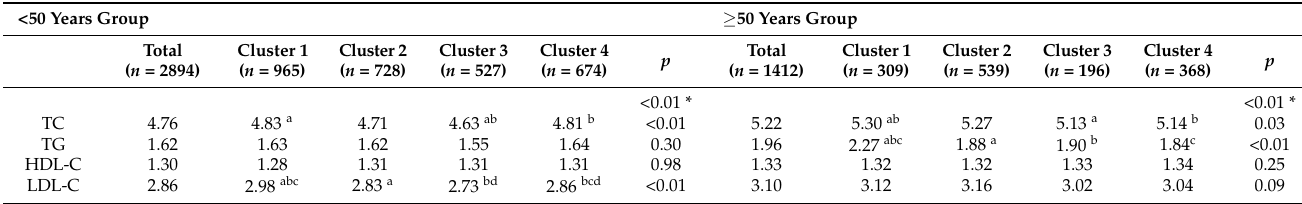
Table 3. Blood lipid profiles of lifestyle behavior clusters.